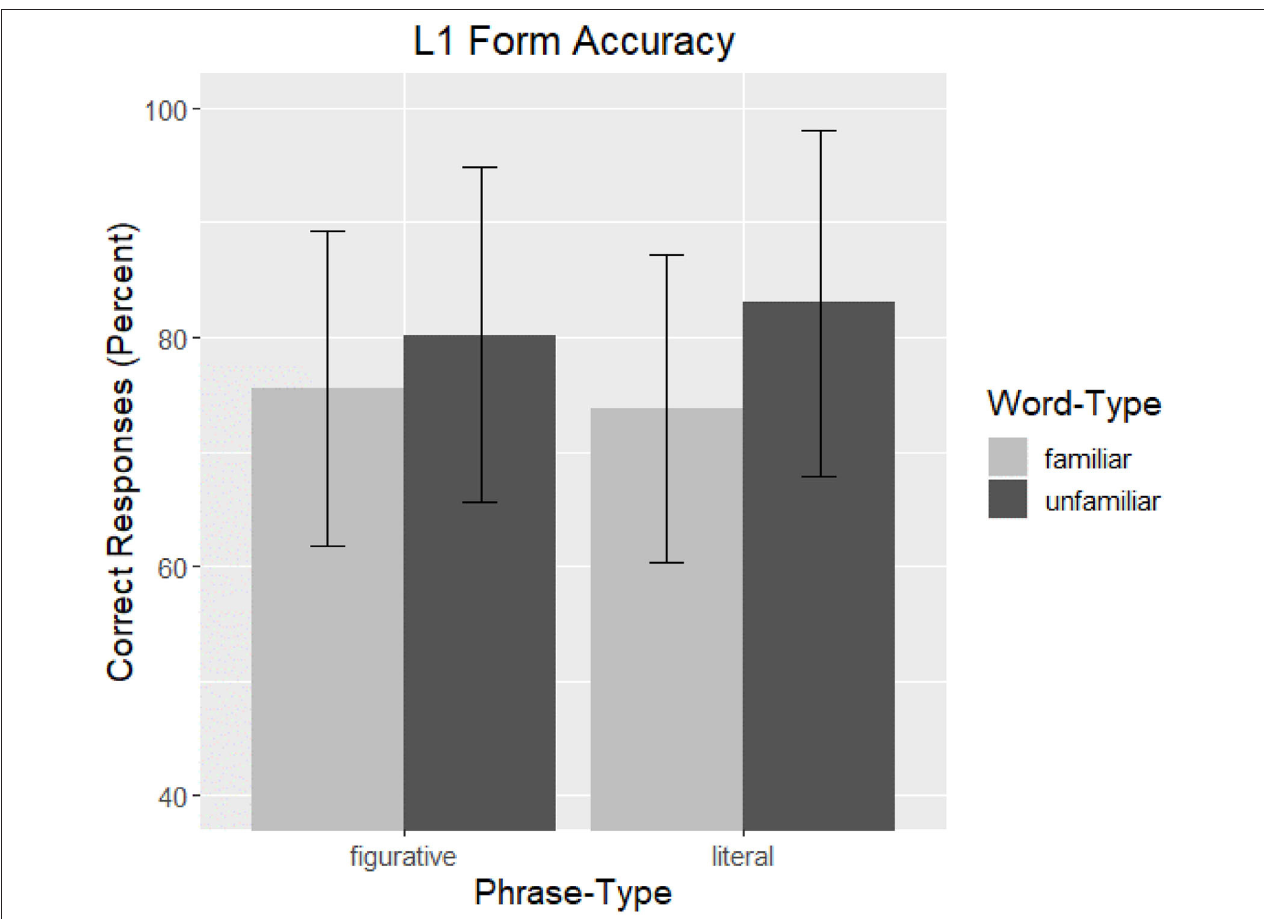
FIGURE 5 | L1 Form Accuracy. The overall correctness of participant responses to form recognition are graphed as a function of Phrase-Type by Word-Type . Familiar words are represented by light gray and unfamiliar words by dark gray, and bars are the standard error of the mean.